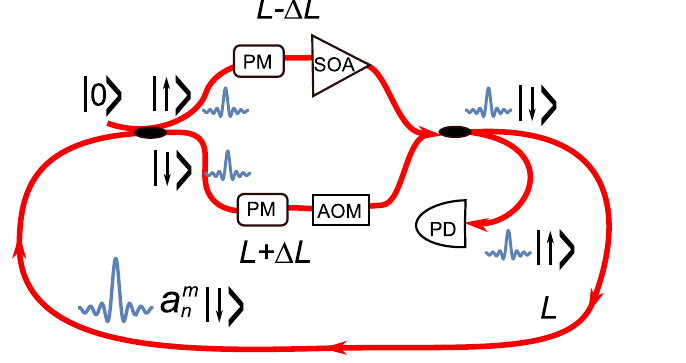
Figure 1. A schematic view of a suggested fiber